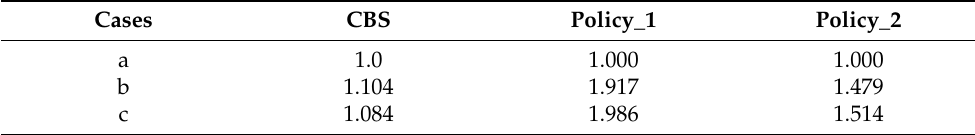
Table 5. The performance metric in the different